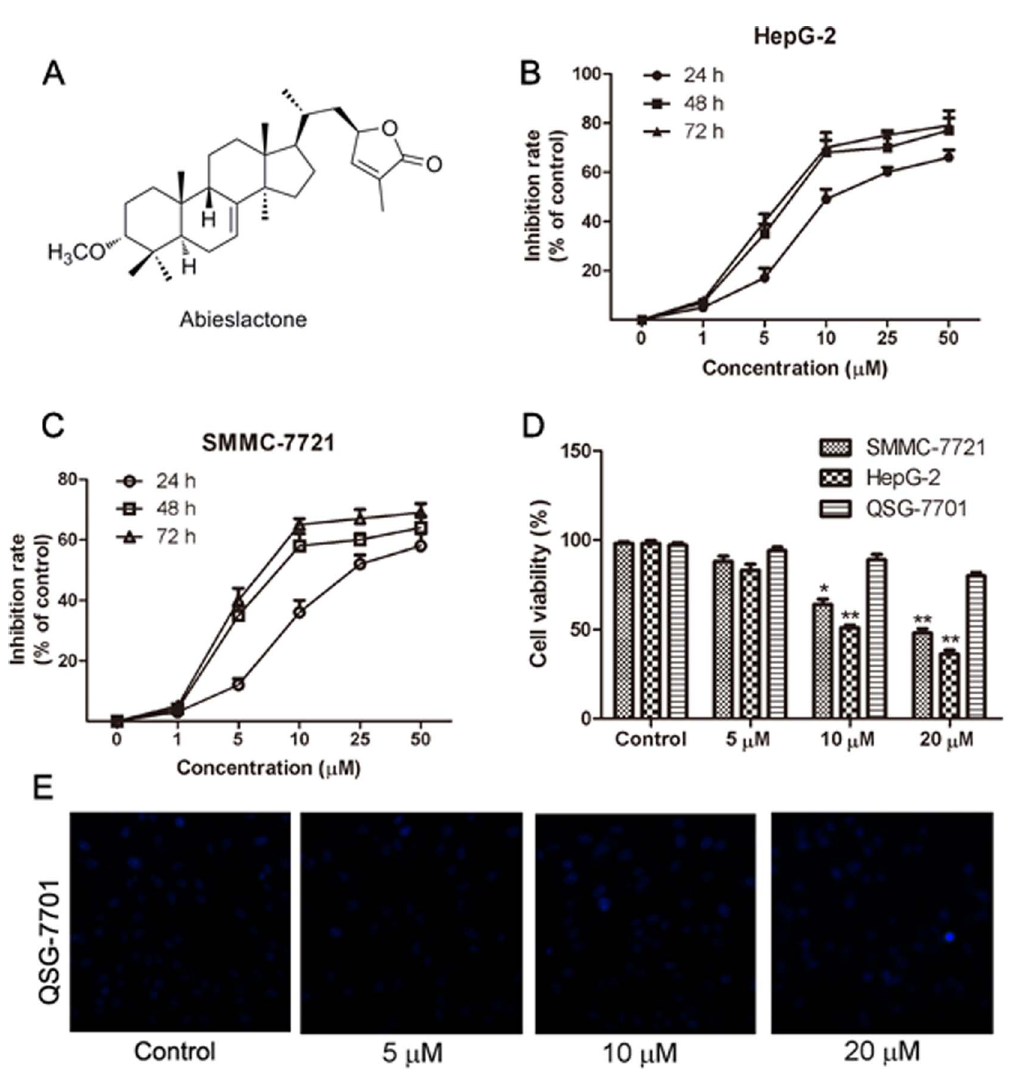
Fig. 1. The chemical structure of abieslactone and its growth-inhibiting effect on HepG2, SMMC7721 and QSG7701 cells. (A) The chemical structure of abieslactone. (B and C) Viability of HepG2 and SMMC7721 cells after exposure to 0.1% DMSO or various concentrations of abieslactone for 24, 48, and 72 h. The data are expressed as the means ¡ SEM of three independent experiments. (D) Cell viability after 5, 10, and 20 m M abieslactone treatment in HepG2, SMMC7721 and QSG7701 cells for 24 h. The results are the mean ¡ SEM from three independent experiments. * P , 0.05; ** P , 0.01 vs . the untreated control. (E) The morphological nuclear changes in QSG7701 cells treated with abieslactone at different concentrations (5, 10, and 20 m M). The cells were stained with Hoechst 33258 for 30 min in the dark to examine the cleaved nuclei, which is a sign of